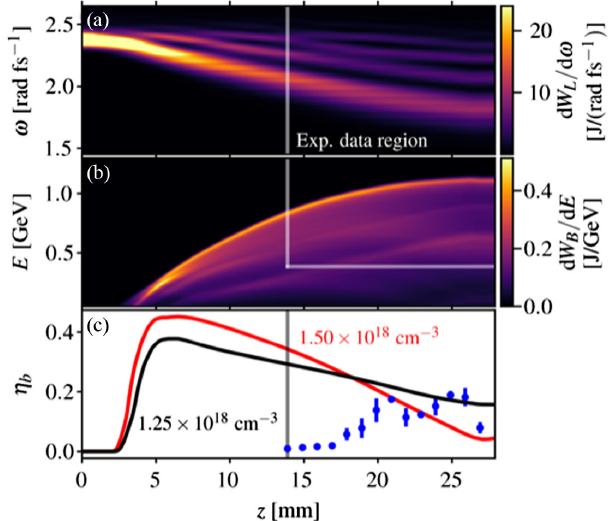
FIG. 3. (a) Laser and (b) electron spectra as functions of propagation distance taken from a PIC simulation with a plateau ¼ 1 . 25 × 10 18 cm − 3 . (c) The extraction efficiency, density of n e calculated as the ratio of the electron beam energy to the laser ¼ ð 1 . 25 ; 1 . 5 Þ × 10 18 cm − 3 energy loss, for simulations with n e ¼ and the experimental measurements (blue points) at n e 1 . 25 × 10 18 cm − 3